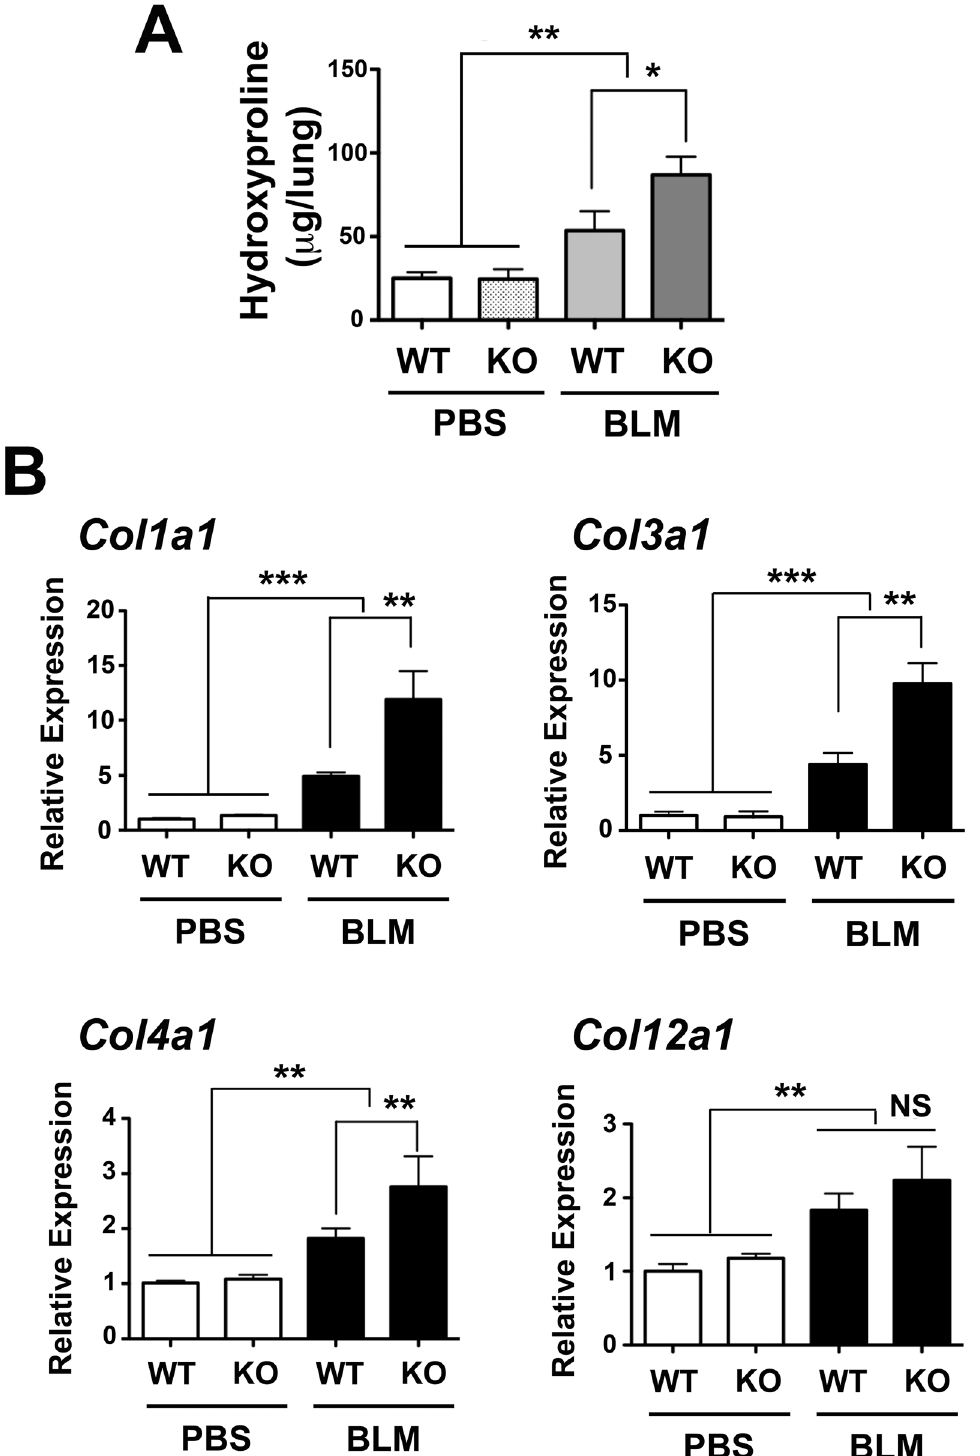
Fig 2. Increased collagens in BLM-treated Scgb3a2 -null lungs. (A) Hydroxyproline content of lungs of wild-type (WT) and Scgb3a2 -null (KO) mice intubated with BLM or PBS as control. The mean ± SD from N > 6 in each group are shown. (B) qRT-PCR analysis of mRNAs for collagen 1a1 ( Col1a1 ), collagen 3a1 ( Col3a1 ), collagen 4a1 ( Col4a1 ), and collagen 12a1 ( Col12a1 ). Normalization control used was 18S. Relative expression levels with the mean ± SD from N > 8 in each group are shown. * P < 0.05, ** P < 0.01, and *** P < 0.001 by one-way ANOVA. NS: not significant.